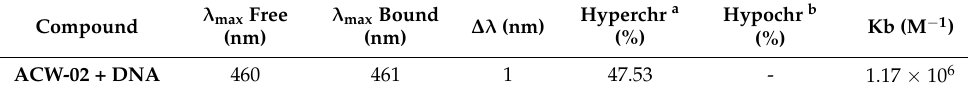
Table 3. UV–vis absorption data of triazolidine acridine in the absence and presence of ctDNA.